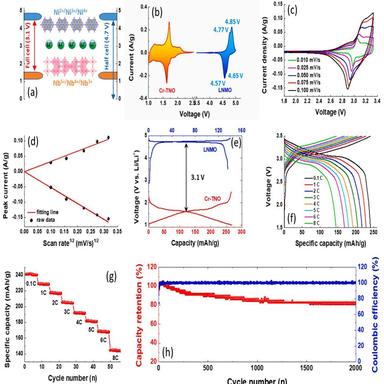
Performance of Cr-TNO//LNMO full LIBs. (a) Schematic representation of the Cr-TNO//LNMO full cell. (b) Typical CV profiles of the Cr-LTO– and LNMO–based half cells. (c) CV profiles of the Cr-TNO//LNMO full cell recorded at various scan rates. (d) Linear relationships of the anodic and cathodic peak current densities and the square root of scan rate (υ1/2). (e) Charge/discharge profiles of Cr-TNO and LNMO. (f) Charge/discharge profiles of the full cell, measured at various C-rates. (g) Rate and (h) cycling p